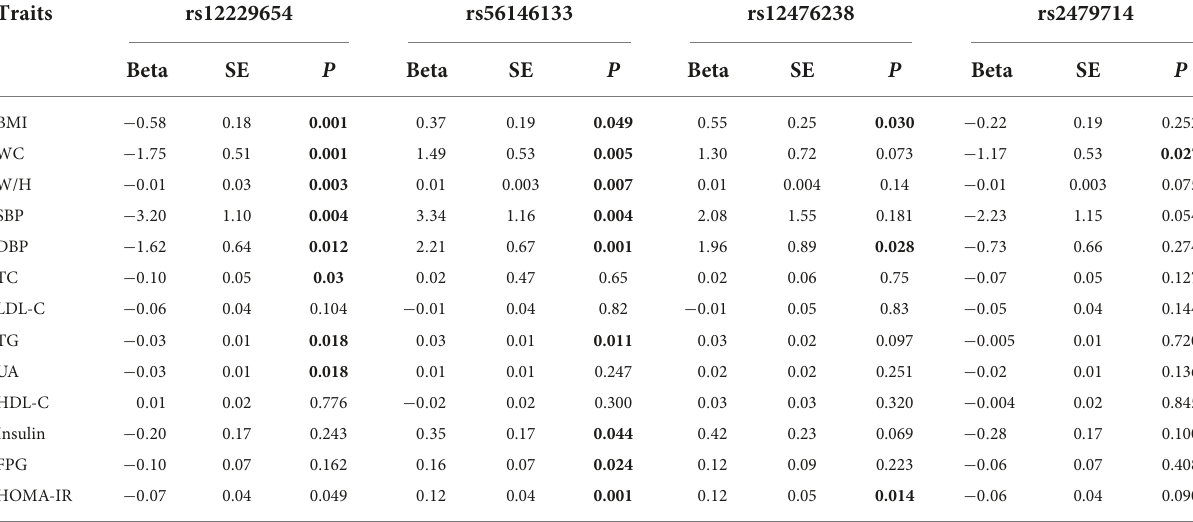
TABLE 3 Associations of Gamma-glutamyl-leucine (Gamma-Glu-Leu)-associated single nucleotide polymorphism (SNPs) with the cardio-metabolic risk factors ( N = 1,062). Traits